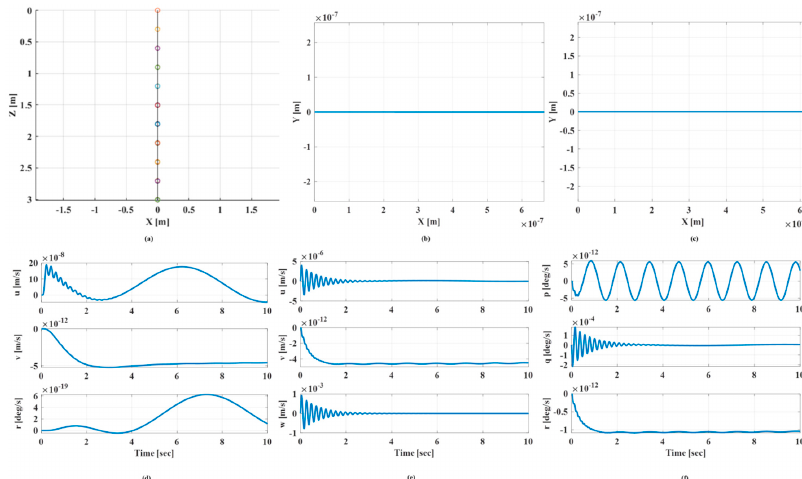
Figure 17. Simulation results of dynamic behavior of unmanned ocean platform when stationary motion: ( a ) X - Z trajectory; ( b ) X - Y trajectory of the USV; ( c ) X - Y trajectory of the UUV; ( d ) Linear and angular velocity of the USV; ( e ) Linear velocity of the UUV; ( f ) Angular velocity of the UUV.